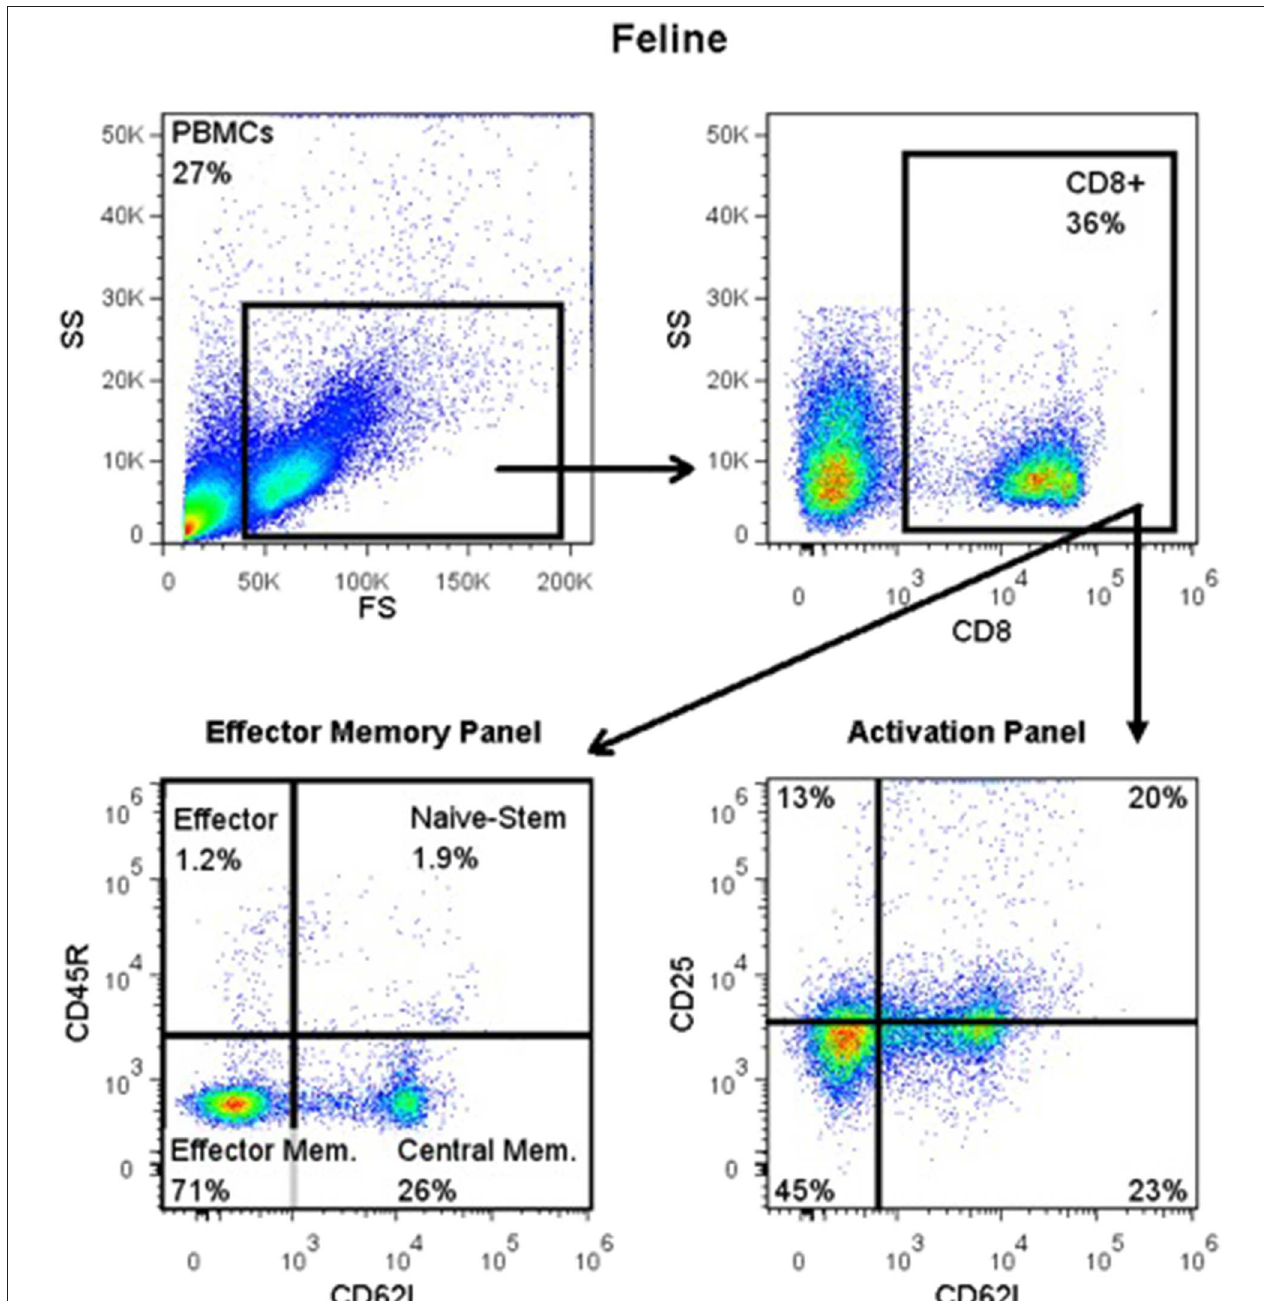
FIGURE 1 | Flow cytometry gating strategy for immunophenotyping of immune cells in the systemic circulation of FCGS ( n = 12) patients along with healthy ( n = 6) controls. General lymphocyte population was identified first using forward and side scatter. Next, CD8 immunofluorescent cells were selected out of the lymphocyte gate. Within CD8 gate, percentages of effector memory (CD8 + CD45-CD62L − ) and central memory (CD8 + CD45-CD62L + ) cells were interrogated. Similarly, within the CD8 positive population, percentages of activated CD8 cells were quantified (CD8 + CD25 + CD62L − ). CD45R antibody utilized here (also known as CD45RABC) recognizes three (A, B, and C) exons of the CD45 protein. These exons are alternatively spliced to generate up to eight different protein products featuring combinations of zero, one, two, or all three exons. CD45 isoforms show cell-type and differentiation-stage specific expression, a pattern which is quite well-conserved in mammals. These isoforms are often used as markers that identify and distinguish between different types of immune cells. Naive T lymphocytes are typically positive for CD45RA, which includes only the A protein region. Activated and memory T lymphocytes express CD45RO, the shortest CD45 isoform, which lacks all three of the A, B, and C regions. This shortest isoform facilitates T cell activation (15).